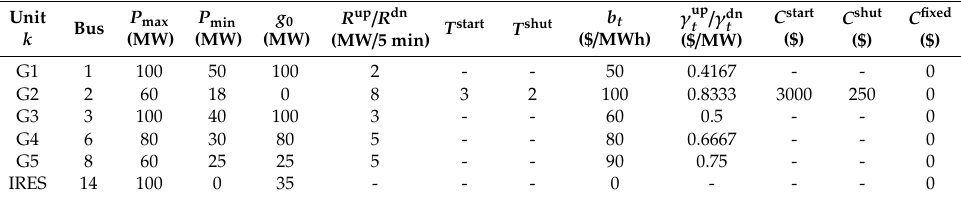
Table 1. Parameters of generating units.